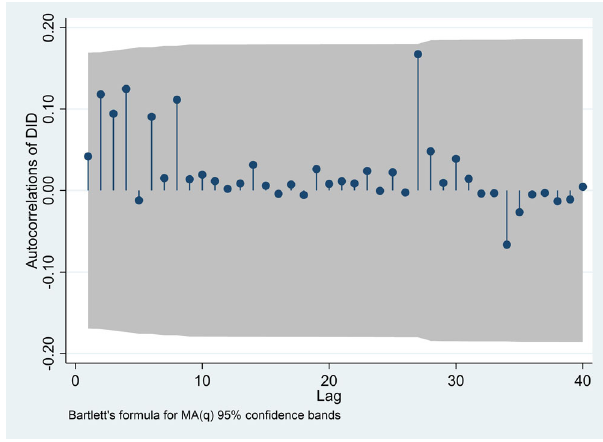
Fig. 11 First order differential partial autocorrelation.